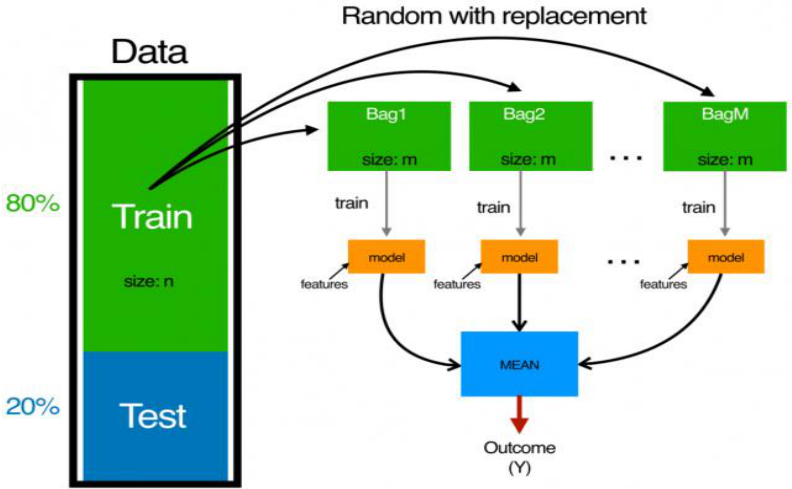
Figure 1. The bagging classifier in detail [25].